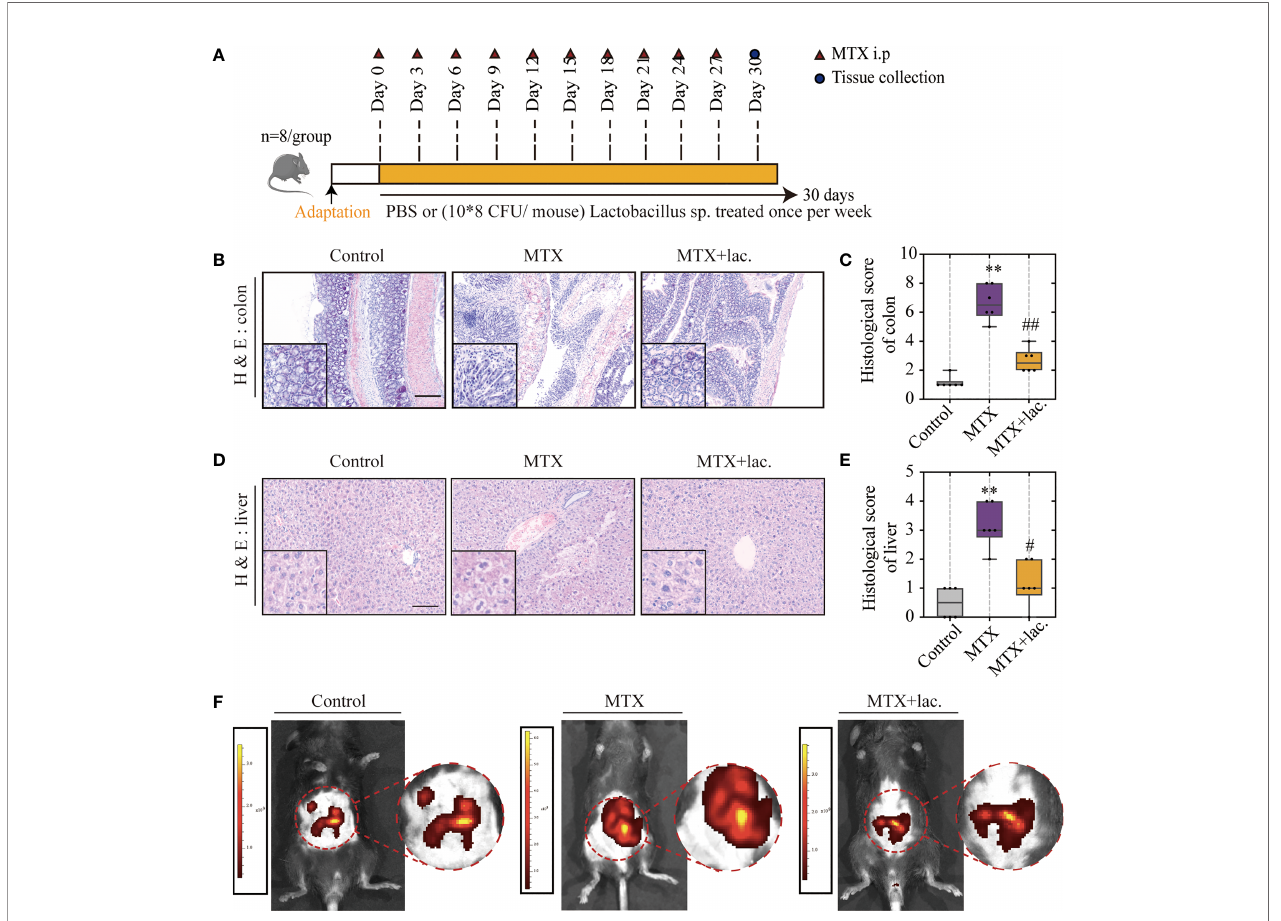
FIGURE 7 | Lactobacillus. sp. can protect the liver and intestine against MTX-induced toxicity. (A) Experiment design. (B, C) Representative H&E staining of liver tissues and histological score, Scale bar, 100 m m. (D, E) Representative H&E staining of colon tissue sections and histological score in each group, Scale bar, 200 m m (n=6, Kruskal-Wallis test). (F) In vivo imaging of FITC-Dextran leakage. **p < 0.01, compared with Control group. # p < 0.05, ## p < 0.01, compared with MTX